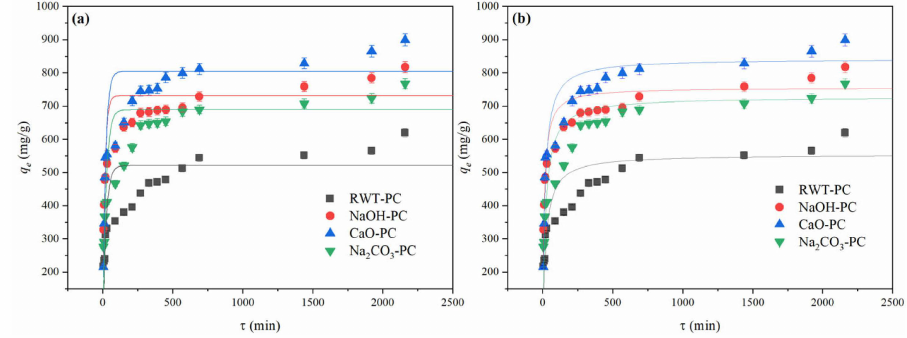
Figure 9. ( a ) Pseudo-first-order (PFO) and pseudo-second-order (PSO) ( b ) fitting curves of PCs